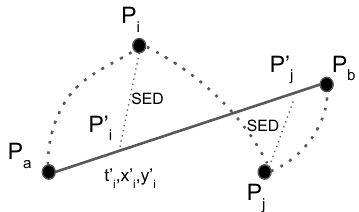
Figure 8. Time ratio algorithm.